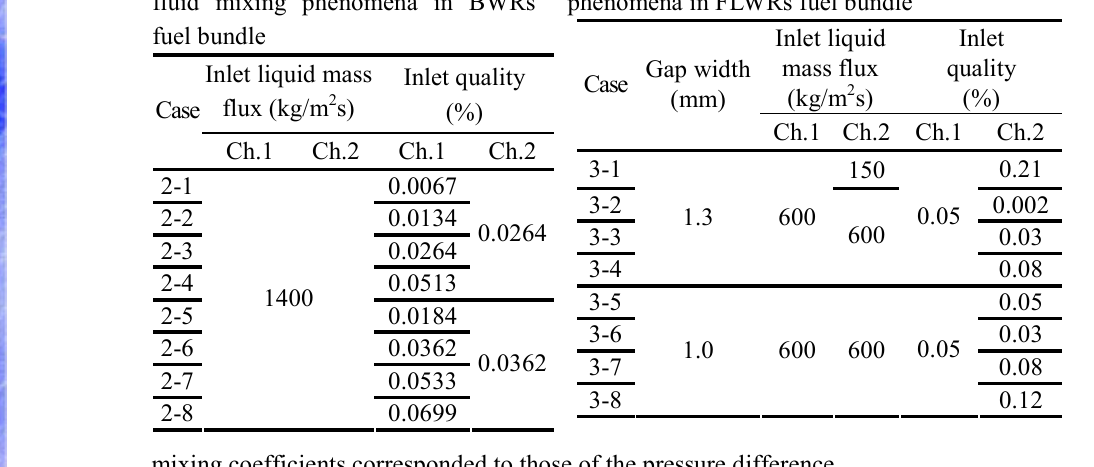
Table 3 Calculation conditions for fluid mixing